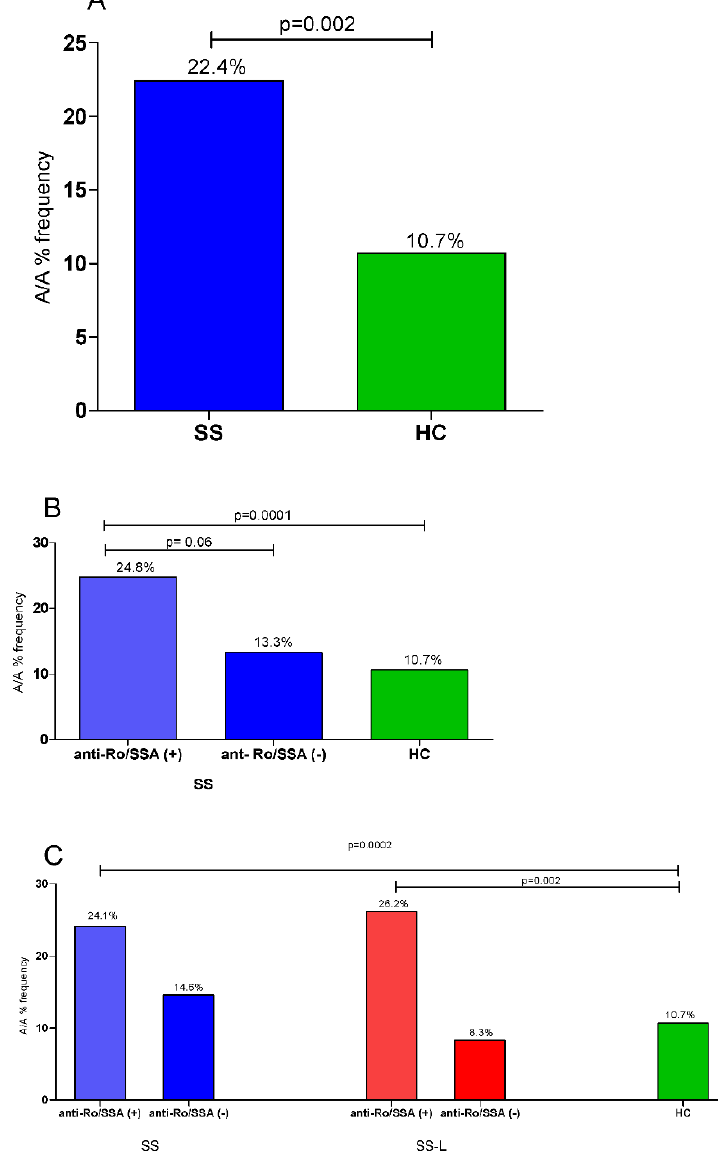
Figure 1. Frequency of the A/A genotype of the IGF1R rs2229765 variant in SS and SS-L patients compared to HCs according to anti-Ro/SSA status. ( A ) Significantly higher frequency of the A/A genotype in the whole SS population compared to HCs (22.4% vs. 10.7%, p = 0.002). ( B ) Significantly increased frequency of the A/A genotype in anti-Ro/SSA positive but not the anti-Ro/SSA negative SS population compared to HCs (24.8% vs. 10.7%, p = 0.0001, and 13.3% vs. 10.7%, p > 0.05, respectively). ( C ) Both anti-Ro/SSA positive SS and SS-L patients displayed increased frequency of the A/A genotype compared to HCs (24.1% vs. 10.7%, p = 0.0002, and 26.2% vs. 10.7%, p = 0.002, respectively). SS: Sjogren’s syndrome; SS-L: Sjogren’s syndrome complicated by lymphoma; HC: healthy control group.